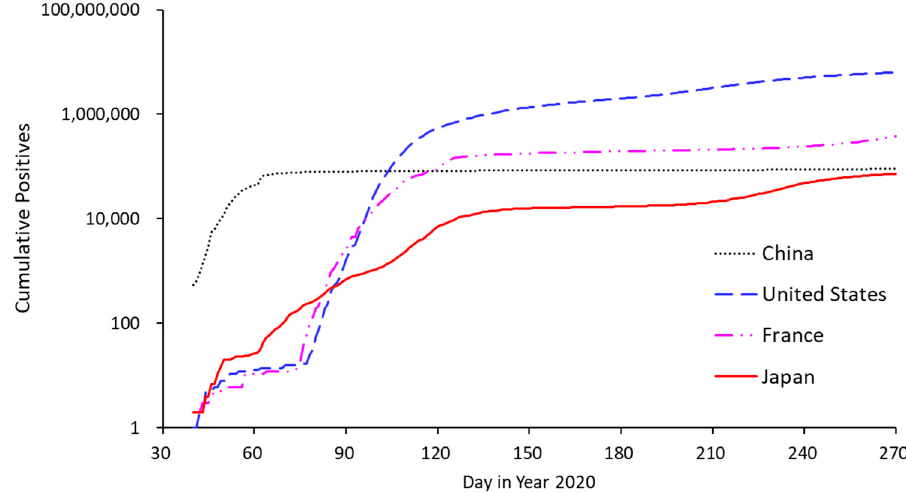
Figure 1. Number of cumulative positive COVID-19 cases in representative early breaking OECD countries (United States, France, and Japan) and positive cases from the epicenter in China. Cases in the epicenter were reduced through strong interventions, while the proportion reached 10% in the United States (highest national proportion). The increase was more gradual in Japan.